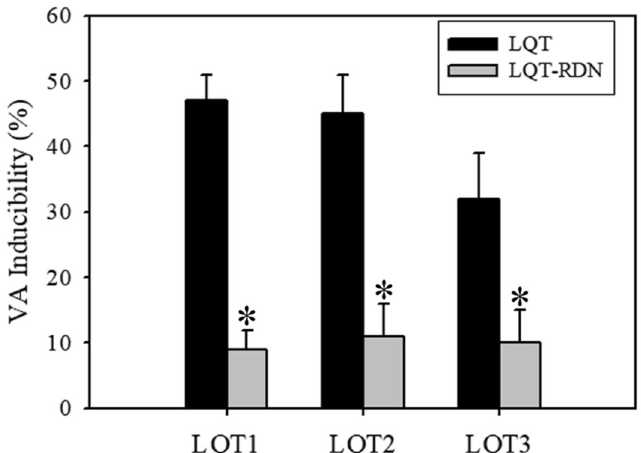
Figure 4. The VA inducibility test of all LQTS subtypes (LQT1, LQT2, LQT3) between the LQT and LQT-RDN groups. (* p < 0.05 compared with the LQT group in each